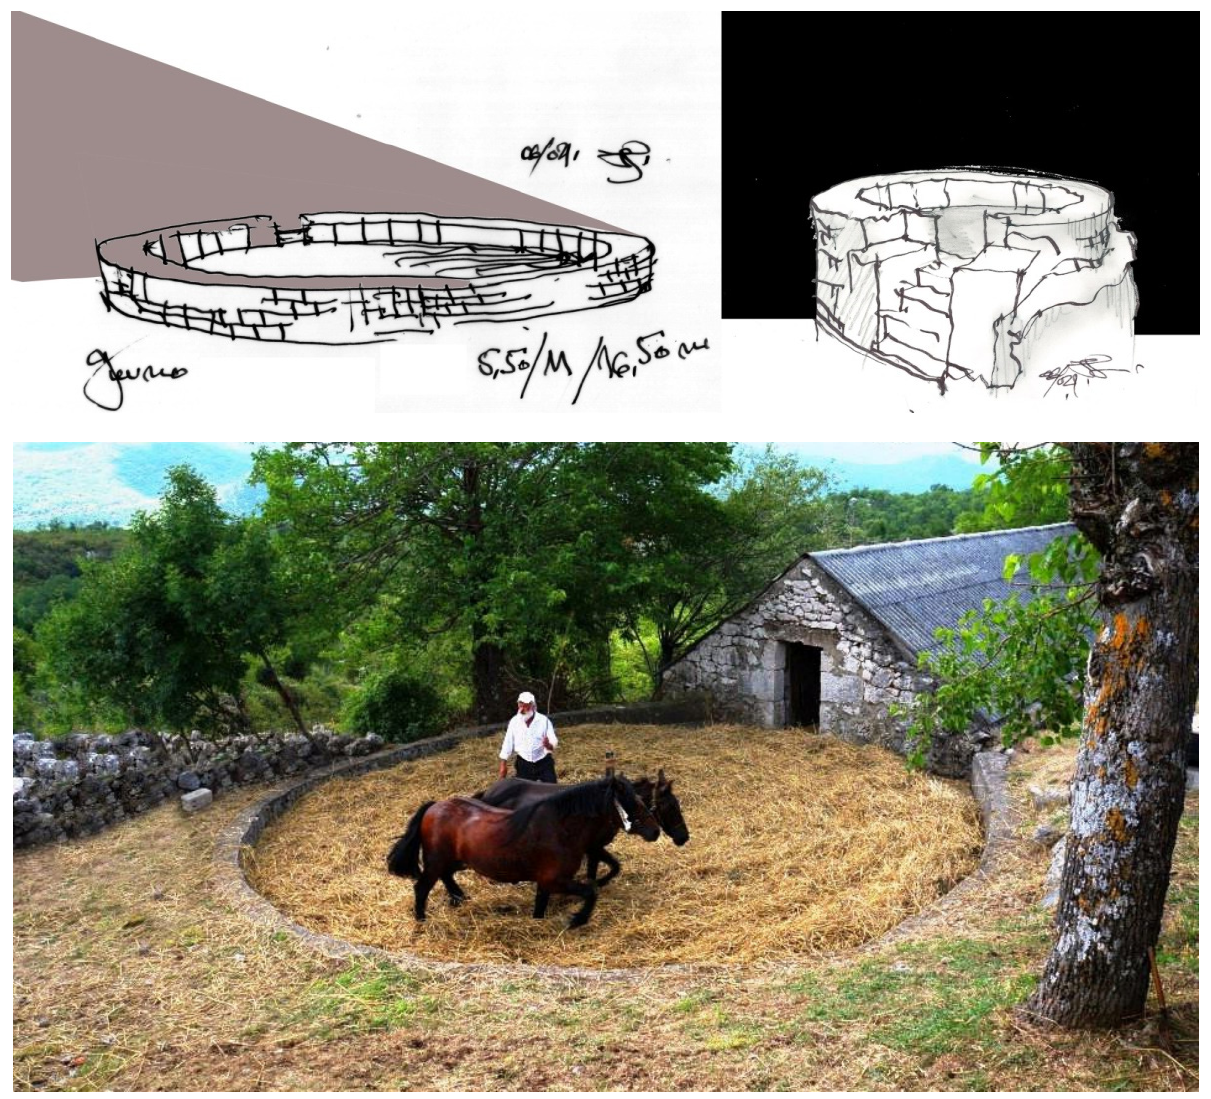
Figure 11. Guvno , Drawings, Svetislav G. Popovic, Photo, Braco Cosic. Of all the buildings of traditional, non-residential construction, we did not record a preserved “guvna”, although their mention in the past of Zeta is not uncommon. A guvno was a place of gathering for rural people, and in Montenegrin traditional culture it is con- sidered a symbol of national cultural